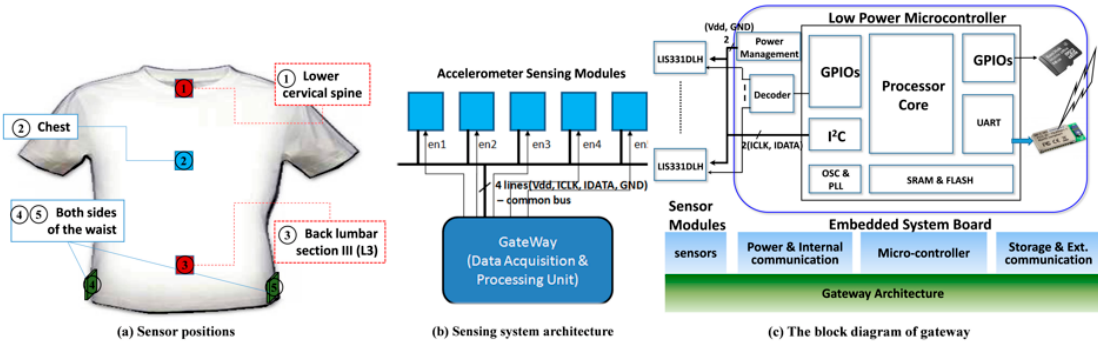
Figure 1. Design of wearable instrumented vest for posture monitoring: ( a ) the sensor positions (dotted lines indicate the sensors at the back of the vest); ( b ) system architecture of the multichannel accelerometer-based sensing system; and ( c ) block diagram of sensing system gateway.